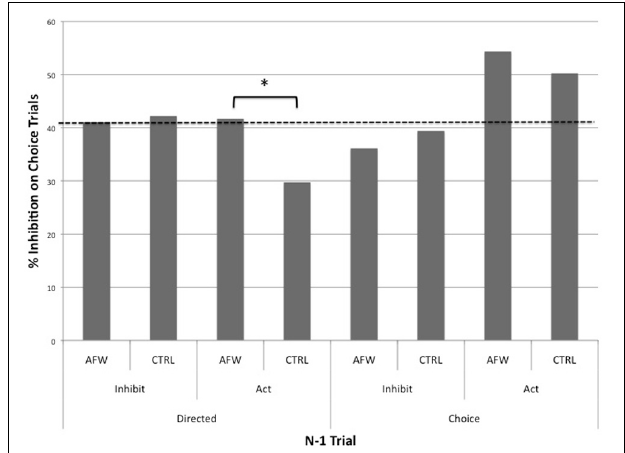
FIGURE 6 | N-1 trial contribution to response tendencies in each experimental group. Compared with anti-free will participants (AFW), control participants (CTRL) tend to inhibit less often following a directed press trial. The dashed line indicates the grand mean proportion of inhibition. ∗ p < 0 .